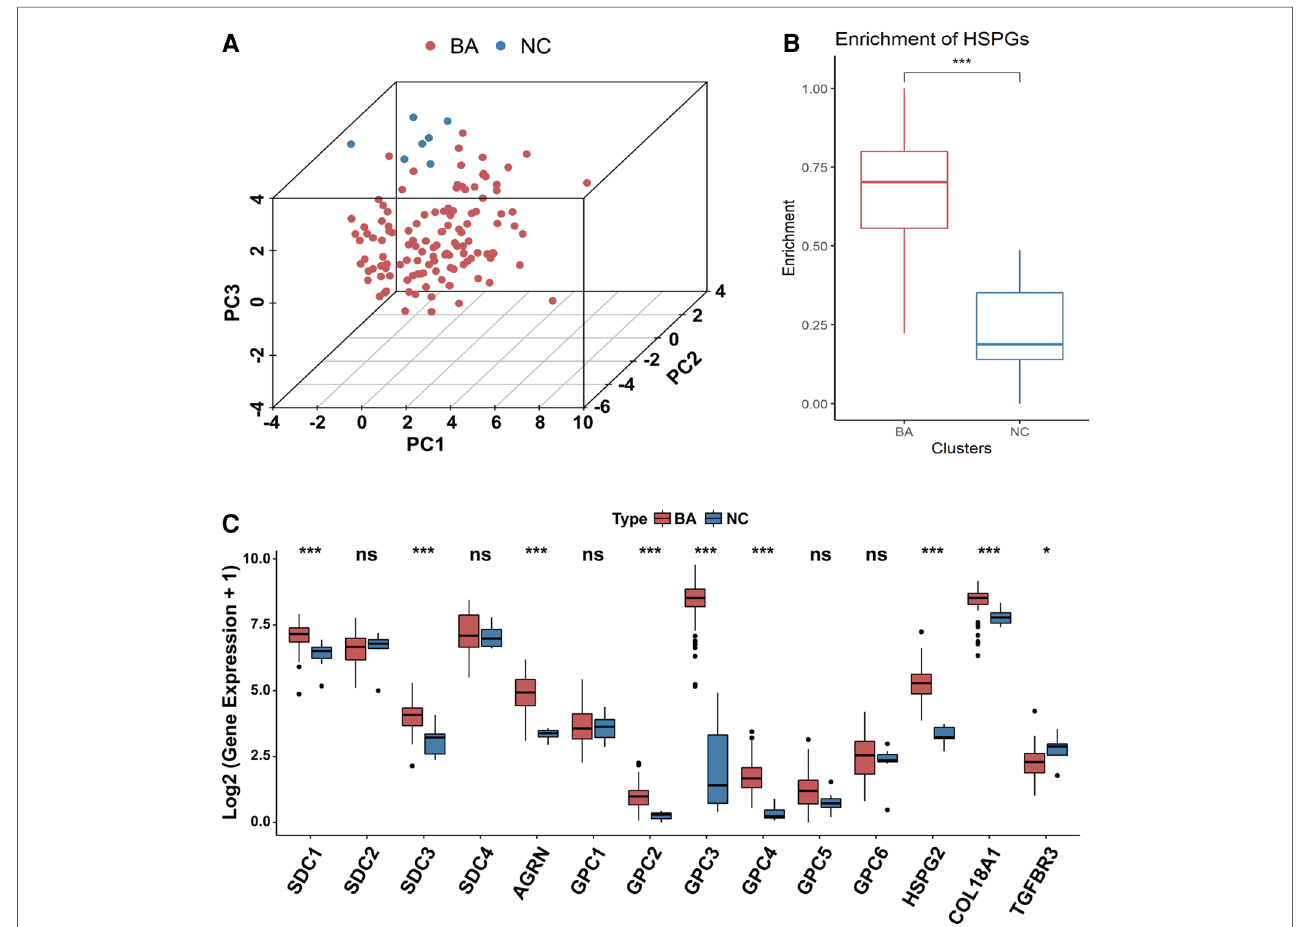
FIGURE 1 Aberrant expression of HSPGs in BA. ( A ) The dot plot of PCA of BA and NC tissues based on HSPGs expression levels. ( B ) The enrichment score of HSPGs in BA and NC livers. ( C ) The expression levels of HSPGs in BA and NC livers. HSPG, heparan sulfate proteoglycan; PCA, principal component analysis; BA, biliary atresia; NC, normal control. ns, not signi fi cant, * p <0.05, ** p <0.01, *** p